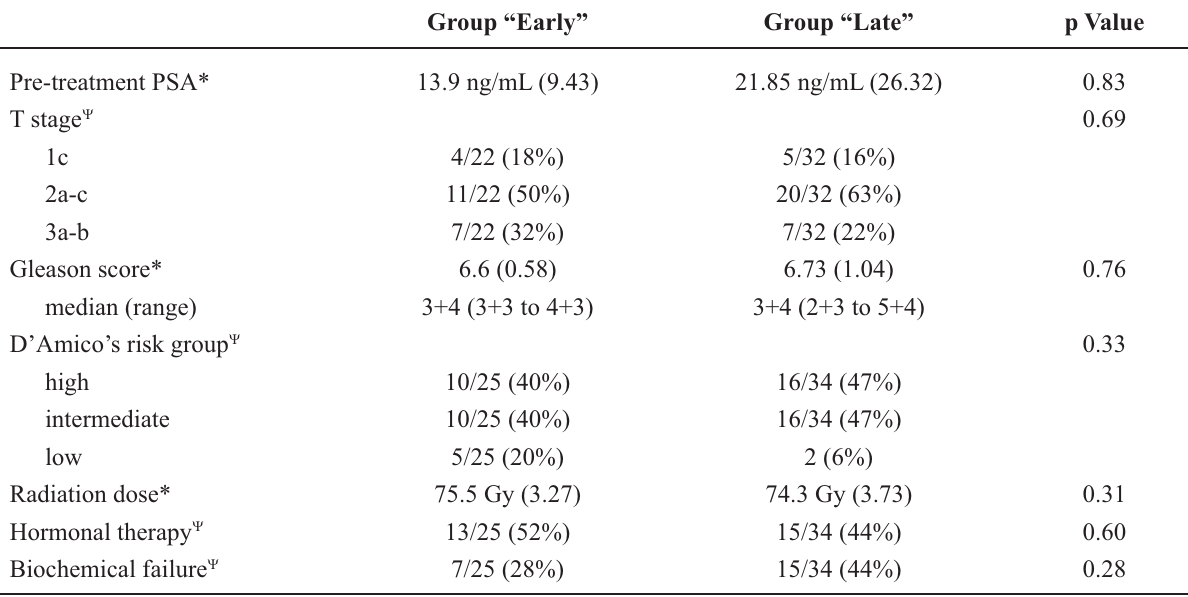
Table 2 – Patients’ characteristics within groups “early” and